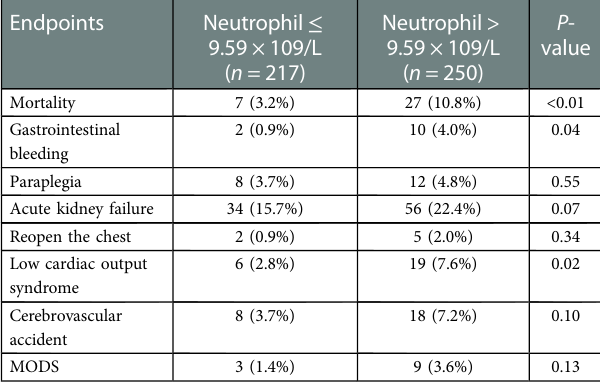
TABLE 2 The endpoints of the different neutrophil groups.